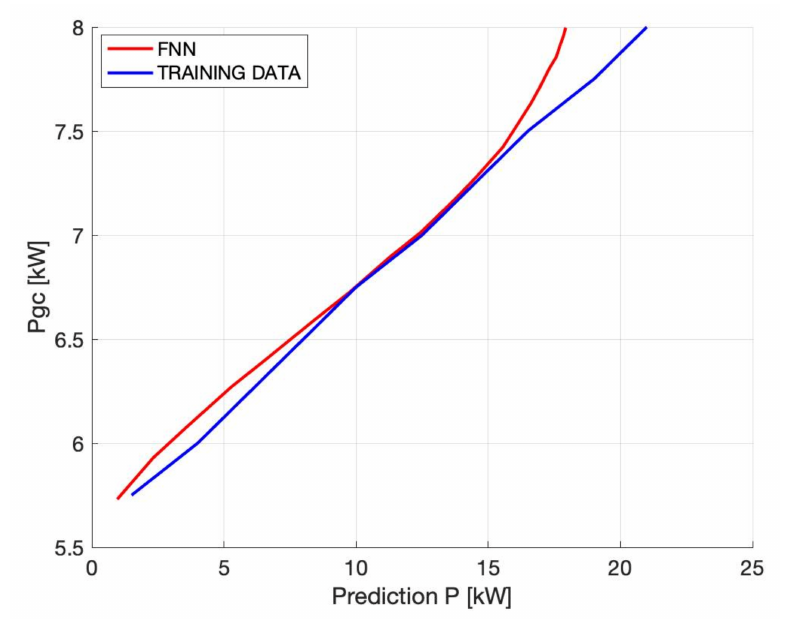
Figure 35. Compilation of the training data with the machine response, scenario 3.